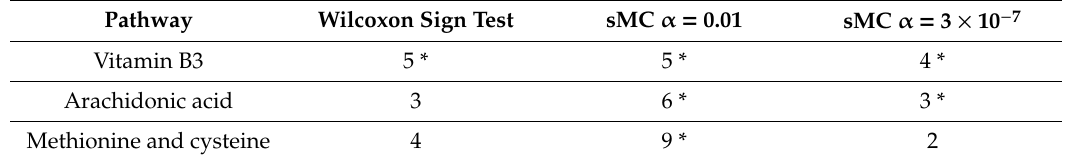
Table 4. Pathways found by Mummichog at a weight tolerance of 1